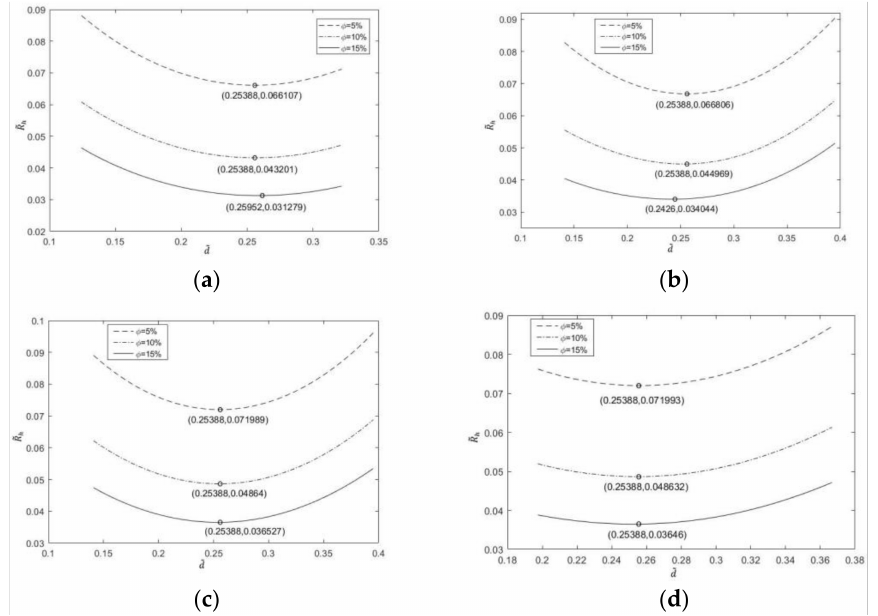
Figure 13. The influence of ϕ on (cid:101) R h in four models at N = 2. Where subfigures ( a – d ) are Model 1, 2, 3 and 4 respectively.